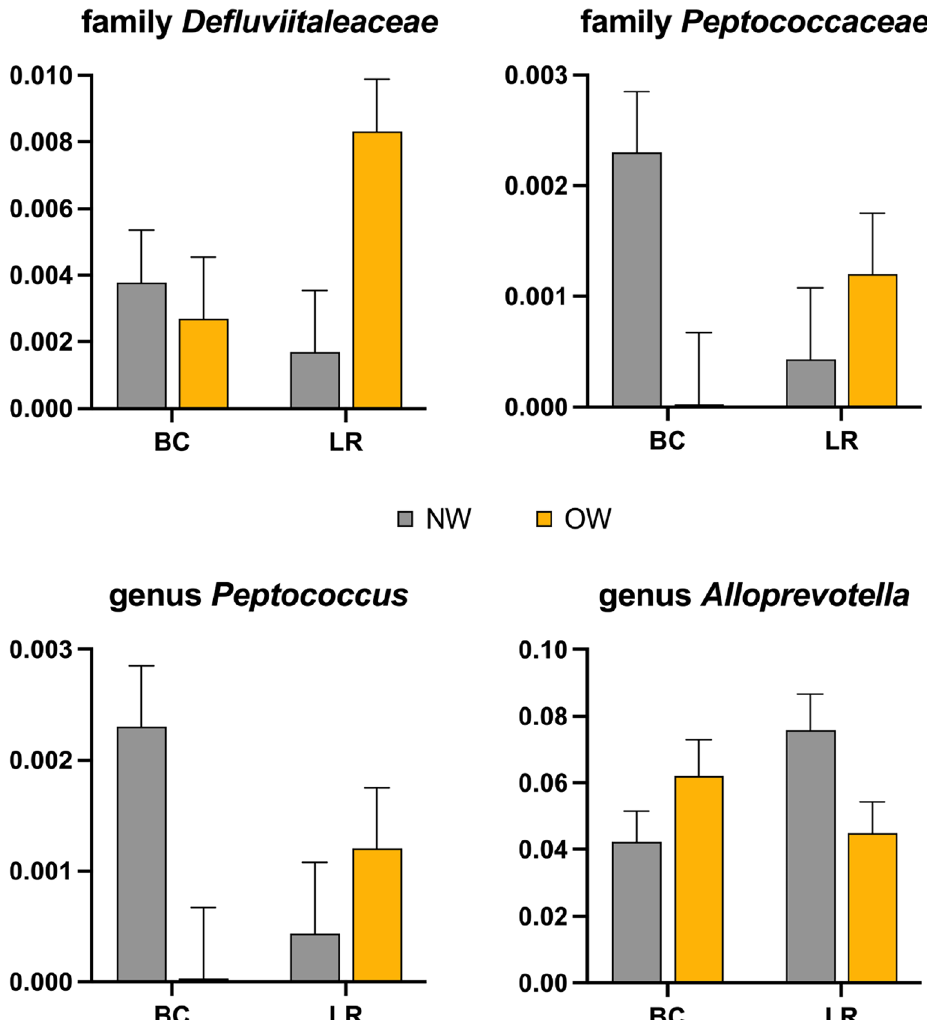
Figure 2. Significantly different bacterial taxa based on the interaction between body condition (lean, NW, n = 15; overweight, OW, n = 14) and breed (Labrador Retrievers, LR, n = 15; Border Collies, BC, n = 14) in the faecal microbiome of the recruited dogs. Data are presented as LSmeans and standard error of % of sequences. This figure was created using GraphPad Prism version 9.3.1 (https:// www. graph pad. com/ scien tific- softw are/ prism/).